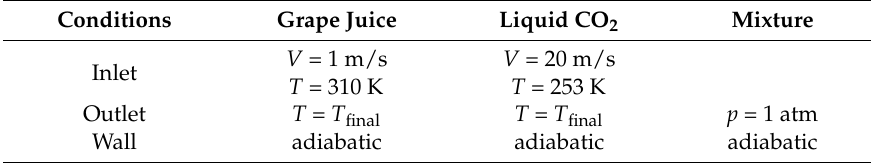
Table 2. Boundary conditions considered.